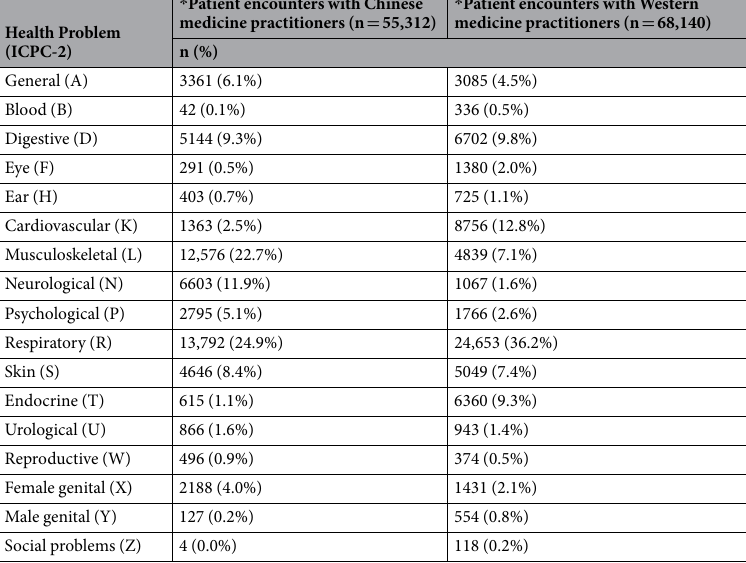
Table 3. Health problems encountered in Chinese and Western medicine 22 settings. * Statistical significance difference between patient encounters in Chinese and Western medicine settings by chi-squared test (p <